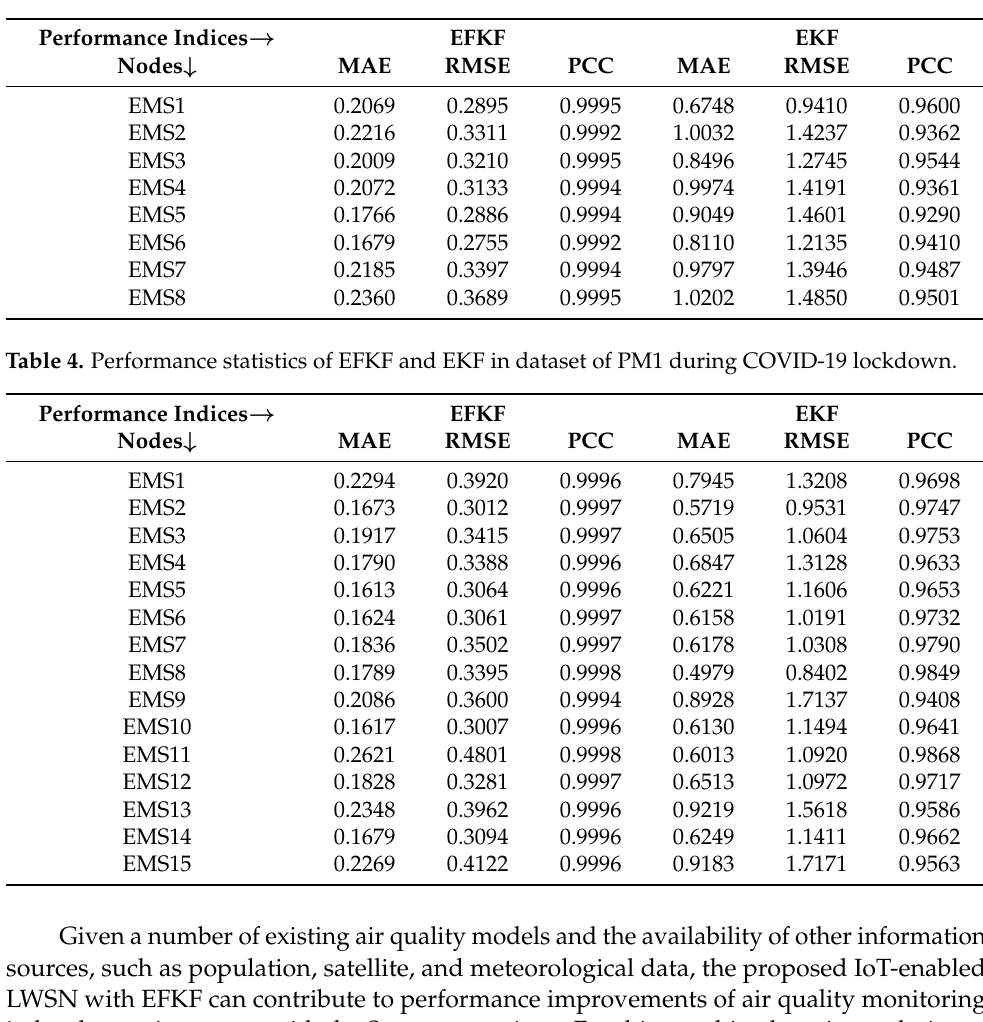
Table 3. Performance statistics of EFKF and EKF in dataset of PM10 during normal session.